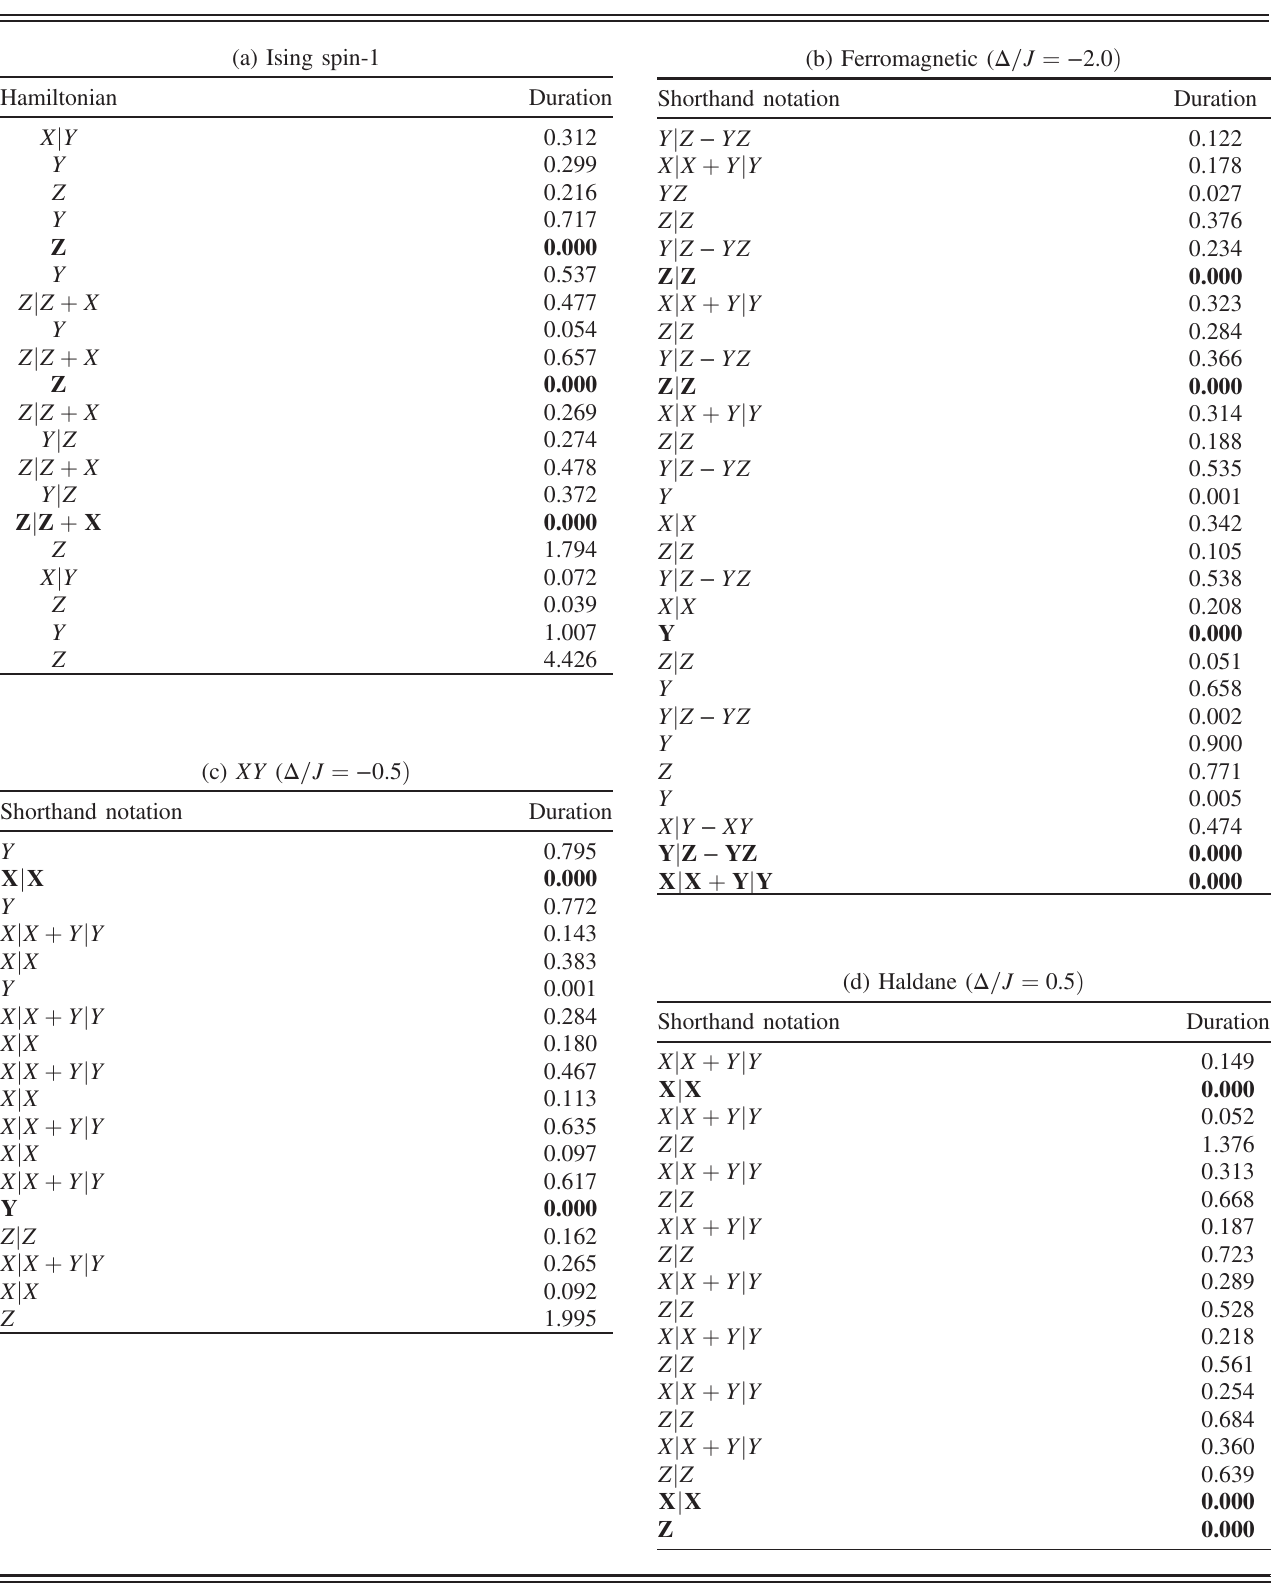
TABLE V. Ising spin-1 chain and anisotropic Heisenberg spin-1 chain, with the protocol sequences and corresponding durations given by CD-QAOA. The protocol (a) correspond to Ising spin-1 in Fig. 24; the (b), (c), (d) three sequences correspond to the three phases in the same setting as Fig. 20. The short-hand notation is the same in Table I. Terms of zero durations are marked bold.